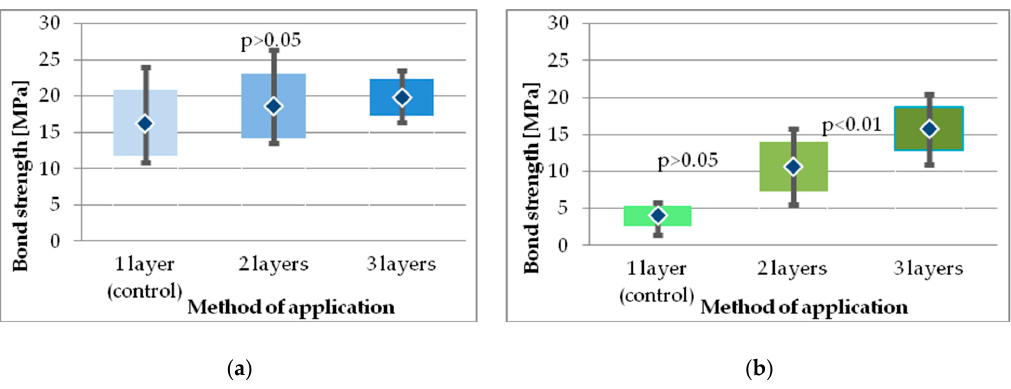
Figure 9. SBS results for multi-mode adhesives: ( a ) Single Bond Universal; ( b ) Prime&Bond One Select.